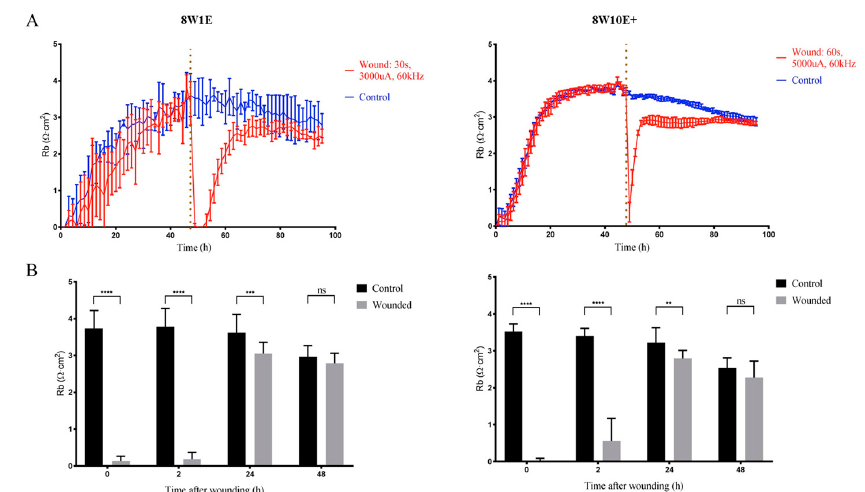
Figure 4. Changes in the barrier resistance over a time course of 48 h post-wounding on the 8W1E and 8W10E+ arrays. ( A ) Time-course of the modelled Rb, the measurement of the endothelial barrier resistance on the 8W1E and 8W10E+ arrays. The hCMVECs were seeded at 0 h at a density of 60,000 cells/cm 2 on both 8W1E and 8W10E+ arrays. The red line represents a wounding current of 3000 uA at 60 kHz was delivered for 30 s to selected wells on the 8W1E array, and a wounding current of 5000 uA at 60 kHz was delivered for 60 s to selected wells on the 8W10E+ array. The vertical line indicates the application of wounding current at 48 h; ( B ) Statistical analysis of the modelled Rb post-wounding compared to those at unwounded state on the 8W1E and 8W10E+ arrays. Data show the mean ± S.D (n = 12 wells assessed from three individual experiments, One-way ANOVA, uncorrected Fisher’s LSD test: ** p ≤ 0.01, *** p ≤ 0.001, **** p ≤ 0.0001, ns = not significant).